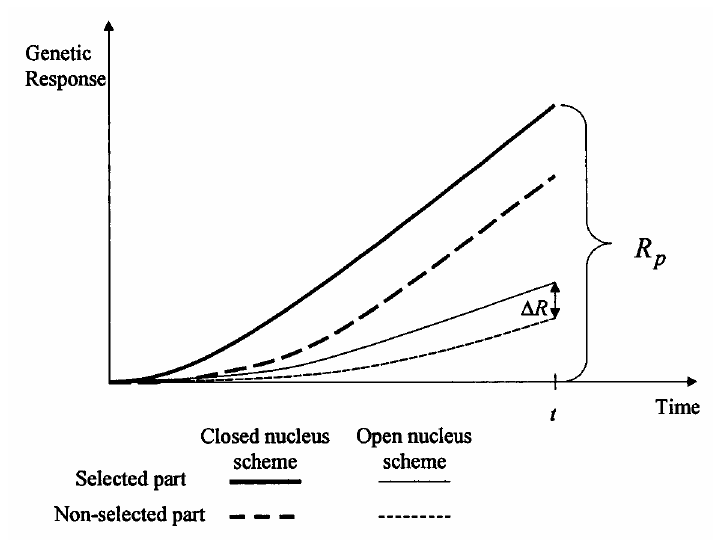
Fig. 3. Avlsframgangen i en lukket avlspopulasjon (close nucleus scheme) der en har kontroll med hvilke bukker som benyttes til avl kan gi rask potensiell genetisk framgang (Rp), også for den delen av flokken som ikke utsettes for seleksjon sammenlignet med et åpent system (Rönnegård, 2003). Dette viser betydningen av en felles strategi innenfor et driftsfelleskap for å realisere og utnytte flok- kens genetiske potensial. I et åpent system vil både selekterte og ikke selekterte bukker for kalvetil- vekst delta i parringene. Dette vil utvanne effekten av framgangen for reineierne som driver seleksjon, samtidig får de som ikke deltar i seleksjonsarbeidet del i framgangen gjennom genstrøm fra de selekterte bukker. En måte å avbøte dette på kan være at bare de reineierne som driver bevist utvalg, setter på avlsbukker som benyttes til å bedekke hele flokken (Rönnegård et al ., 2003). Dette vil imid- lertid gi et mindre antall bukker å velge avlsbukker fra. Et slikt halvlukket system kan være mindre ro- bust spesielt i forhold til innavl og avhenger også av andelen av flokken som deltar i seleksjons- arbeidet. Rönnegård et al . (2003) har imidlertid beregnet at dette ikke er et problem i vinterflokker over 2000